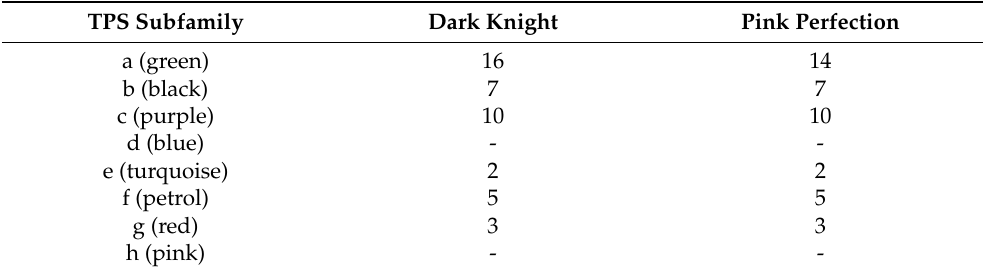
Figure 5. Gene Ontology term classification within molecular functions of Pink Perfection, clustered with nucleic acid binding: DNA binding, RNA binding, Nucleotide binding. Figure was drafted employing REVIGO [59] and customized with R. Value and log size represents the counted GO terms across annotated gene models. Table 4. Terpene synthase (TPS) subfamilies and their distribution in the Caryopteris x clandonen- sis cultivars Dark Knight and Pink Perfection. TPS-a, -b and -c show the highest prevalence in both